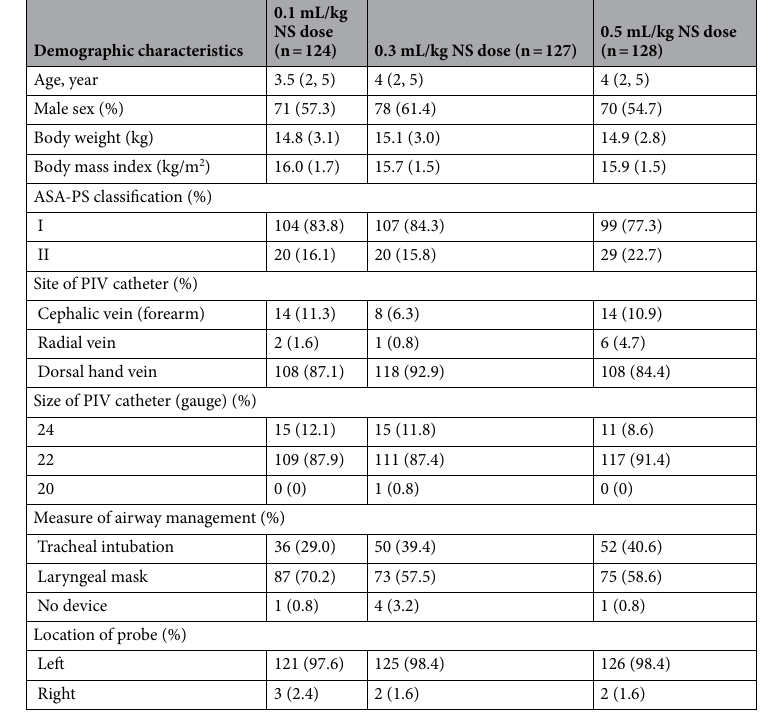
Table 1. Patient characteristics (n = 379). Data presented as median (25th, 75th percentile) or No. (%). ASA-PS, American Society of Anesthesiologists Physical Status; NS, normal saline; PIV, peripheral intravenous catheter.